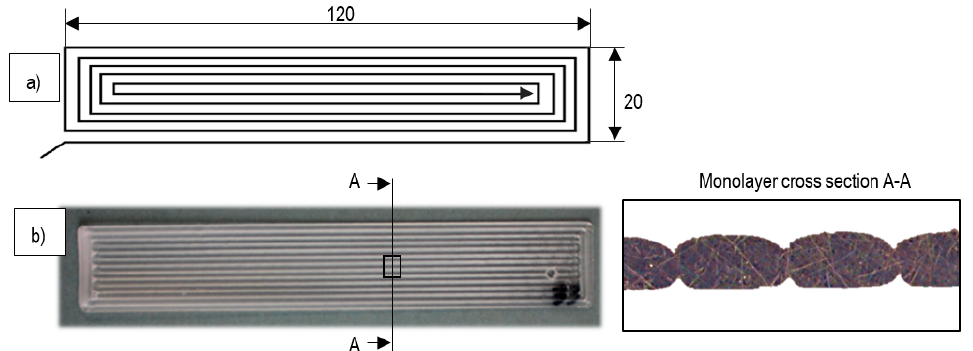
Table 1. Characteristics of the poly(lactic acid) (PLA) according to the manufacturer.